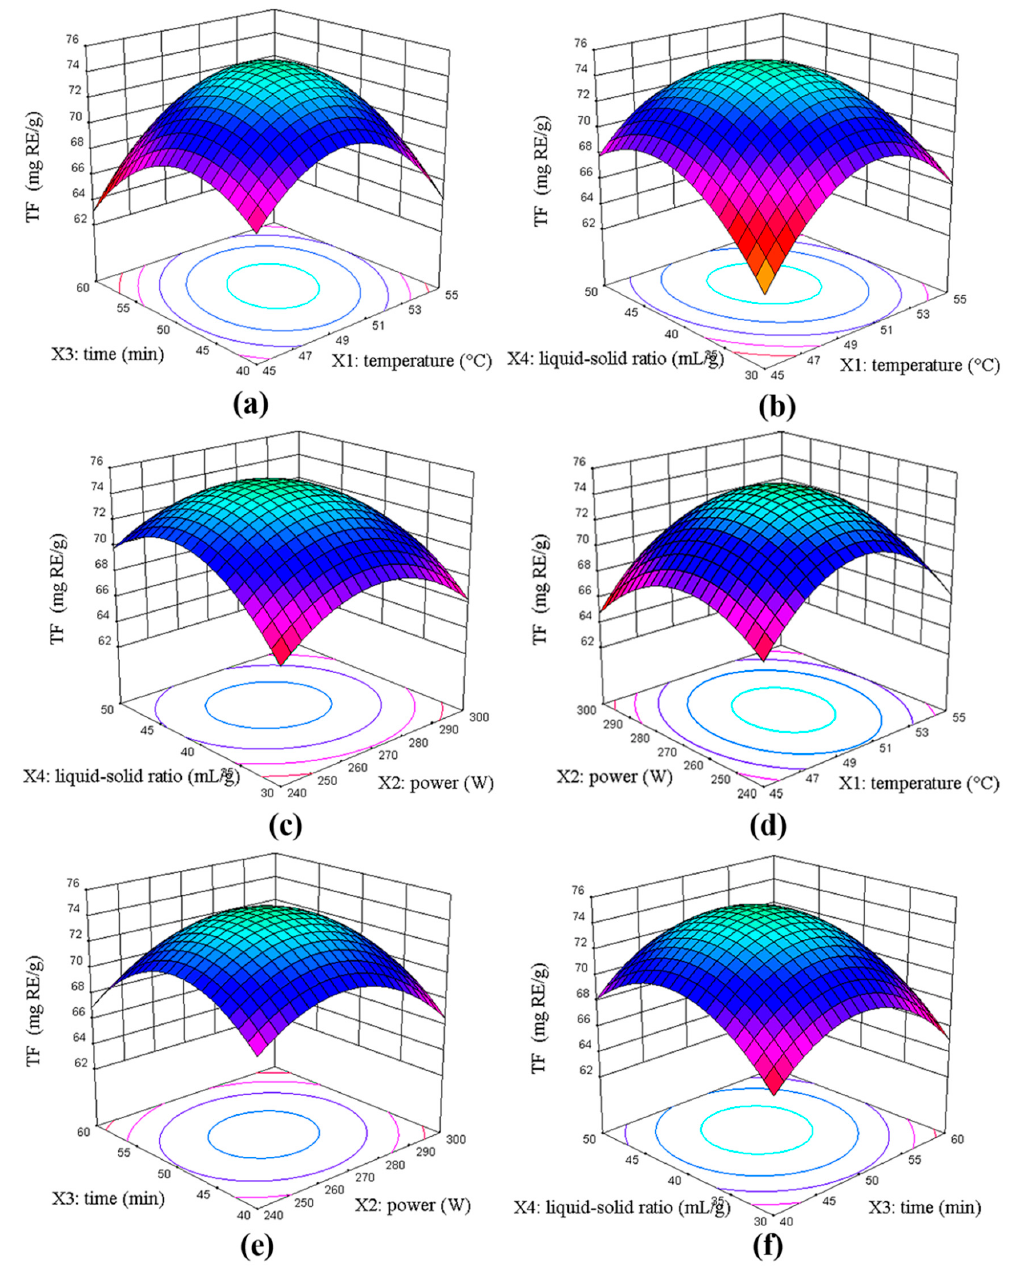
Figure 2. Response surface plots of the four factors interaction on the total flavonoids (TF) yield. ( a ) temperature and time (power 270 W, liquid-solid ratio 40 mL/g); ( b )temperature and liquid-solid ratio (power 270 W, time 50 min); ( c ) power and liquid-solid ratio (time 50 min, temperature 50 °C); ( d ) power and temperature (time 50 min, liquid-solid ratio 40 mL/g); ( e ) power and time (temperature 50 °C, liquid-solid ratio 40 mL/g); ( f ) time and liquid-solid ratio (temperature 50 °C, power 270 W).